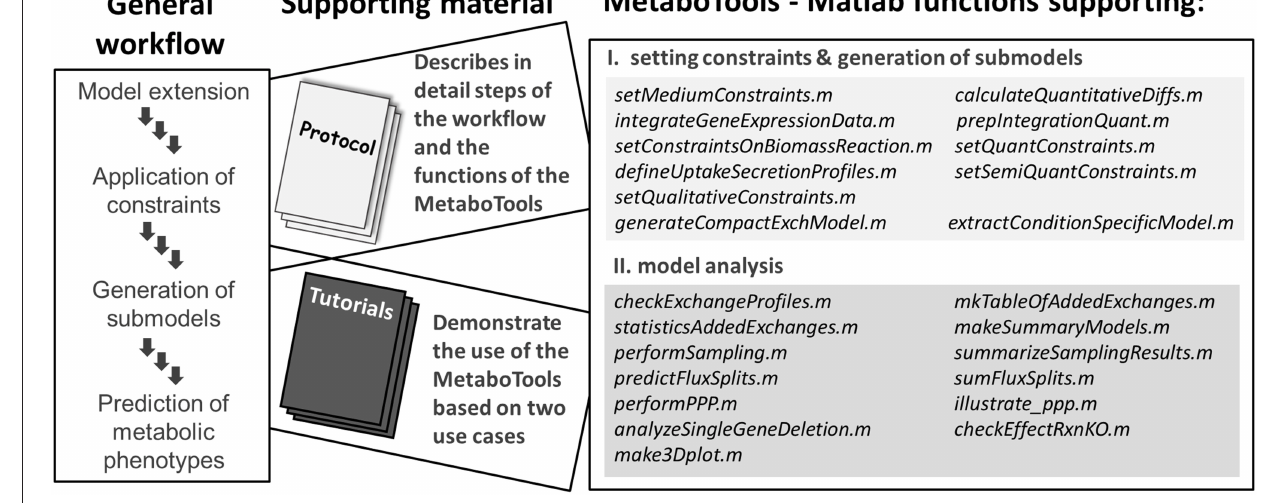
FIGURE 1 | This protocol and the MetaboTools provide comprehensive support for the integration of extracellular metabolomic data and for the analysis and phenotypic stratification of metabolic models. The workflow captures the integration of processed and annotated metabolomic data sets, the generation of contextualized submodels, and the computational model analysis to distinguish metabolic phenotypes. Each part of the workflow is discussed in detail in the protocol and supported by the MetaboTools Matlab functions. The tutorials (Supplementary Tutorial I, II) demonstrate two use-cases of the workflow and MetaboTools.